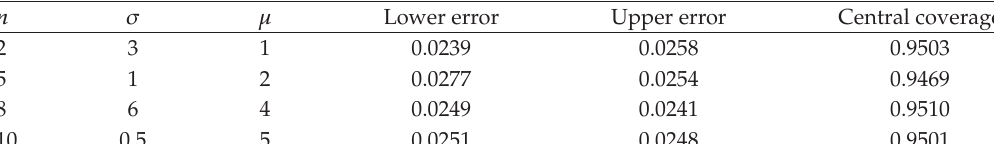
Table 5: Results from simulation studies and the parameter of interest are μ using the approximate Studentization method.